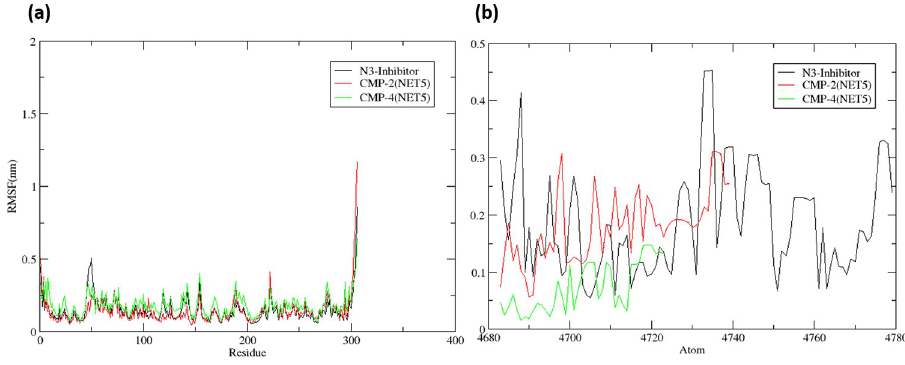
Fig 7. The RMSF for CMP2 (NET5) , CMP4 (NET5) and reference ligand N3 complexes, calculated over 100 ns MD simulation trajectories for (a) protein and (b) ligands.